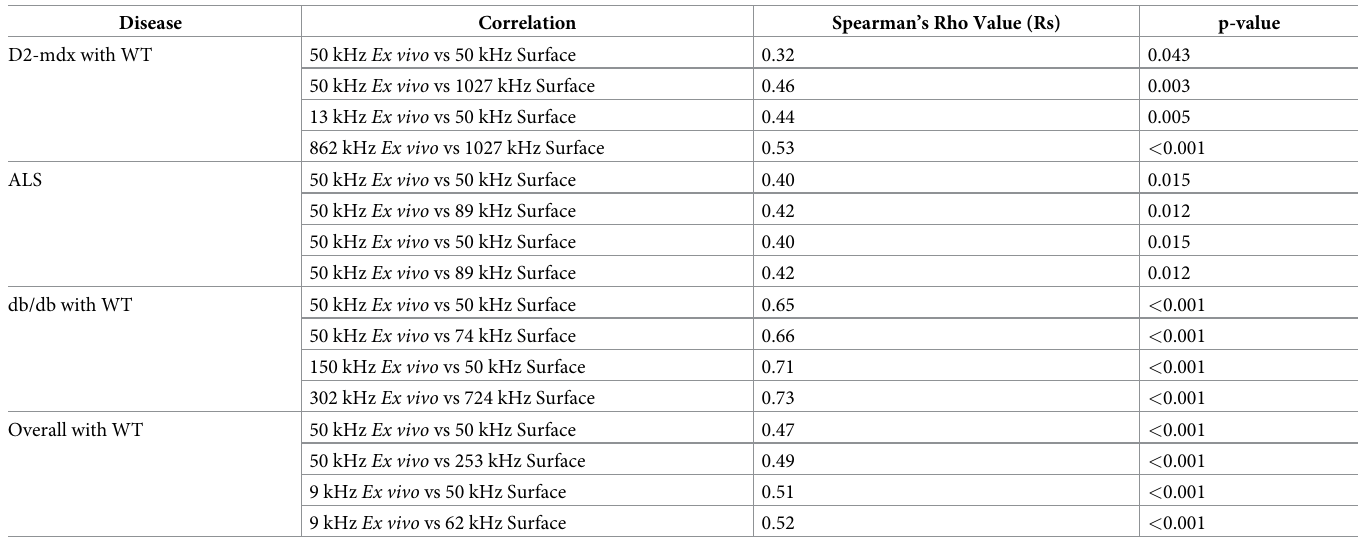
surface and ex vivo (Panel B); the surface frequency with the highest Rs value with 50 kHz ex vivo (Panel C); the 50 kHz surface frequency with the ex vivo frequency with the highest Rs val- ues (Panel F); and finally, the correlation with the highest Rs value from the entire frequency spectrum (Panel E). Table 3. Longitudinal Resistance (LR) value correlations. Disease